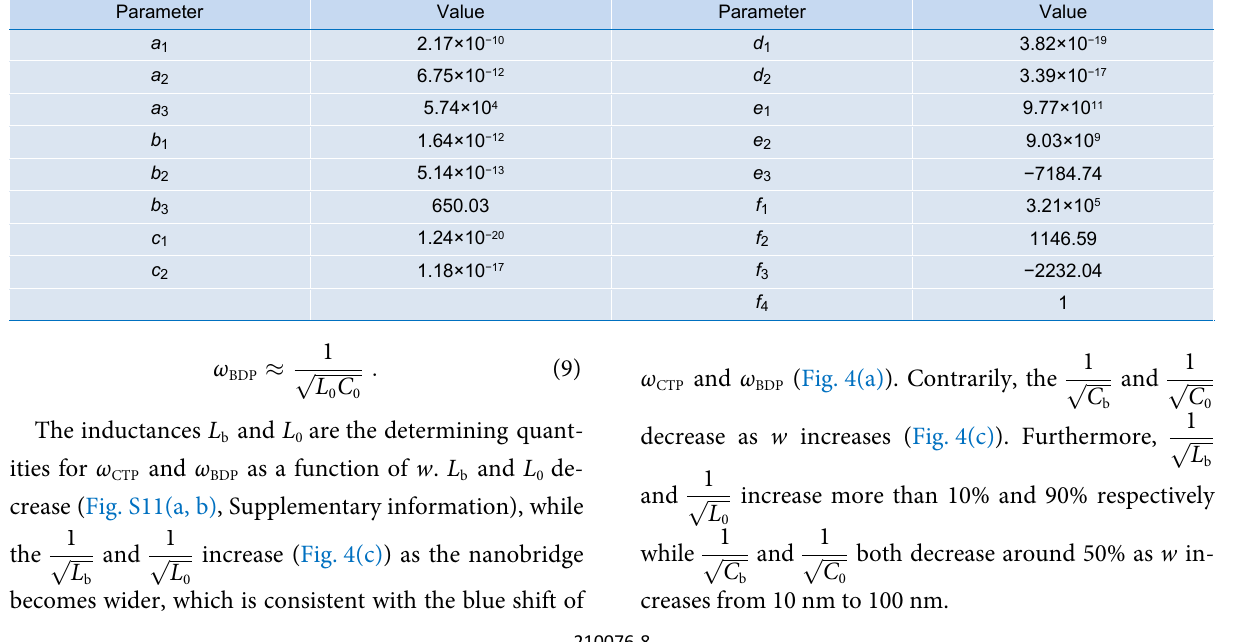
Table 1 | Fitting parameters used in the RCL circuit